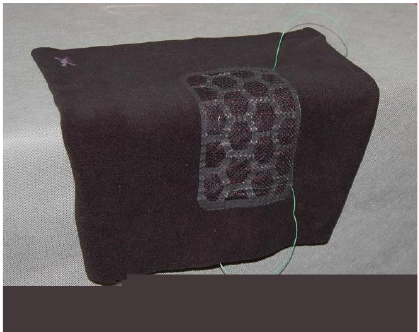
Figure 3. Photograph of the heating insert (variant B) hanging from a shelf. Table 2. Characteristics of the heating inserts.